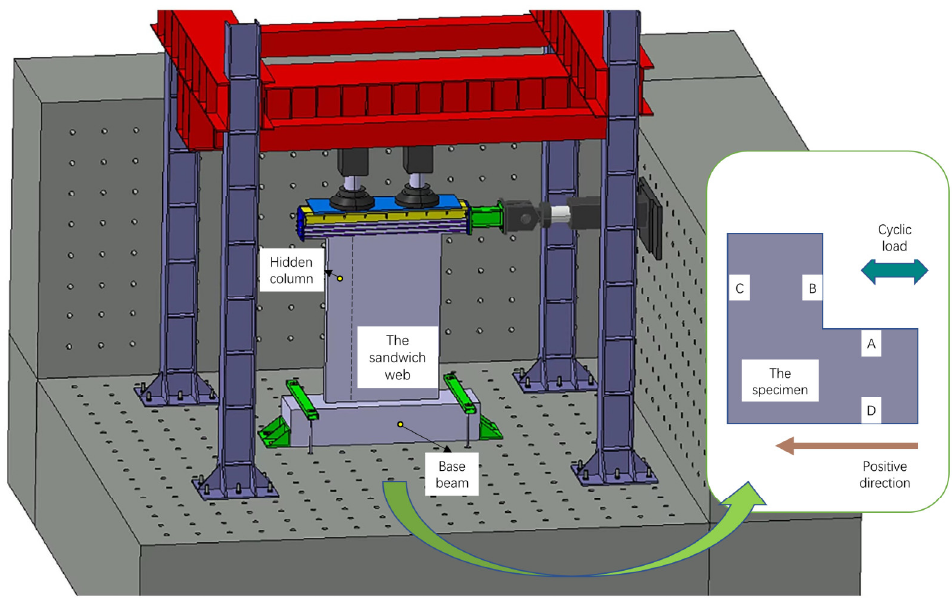
Figure 4. Test setup.